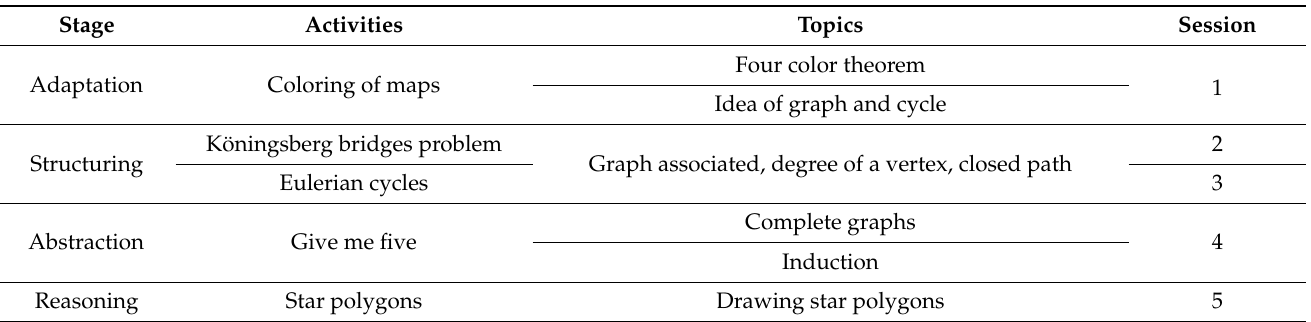
Table 1. Sessions, topics and activities in the original